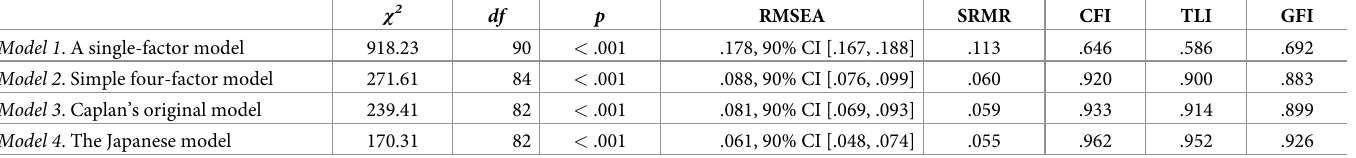
Table 3. Goodness-of-fit of the models: Results of confirmatory factor